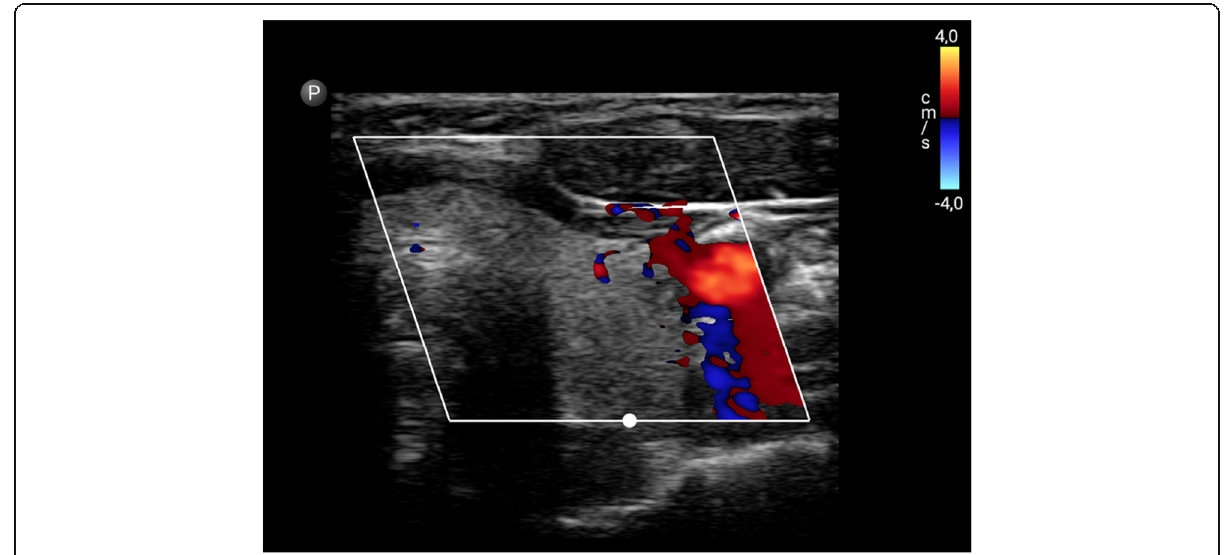
Fig. 6 Philips Lumify linear transducer: Colour Doppler of the left thyroid lobe including the carotid artery